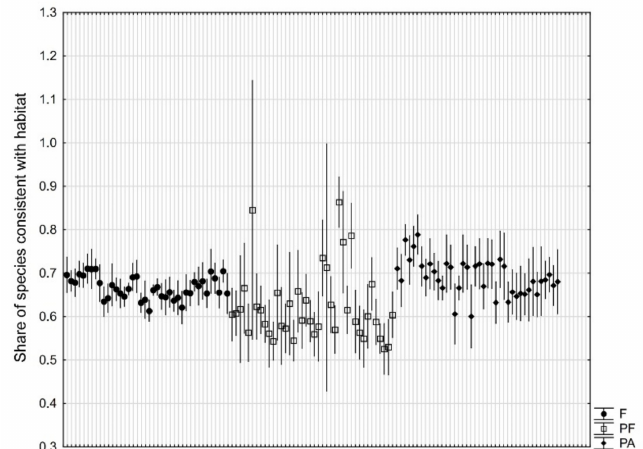
Figure 5. Number (mean ± 95% confidence interval based on 10 research plots of 100 m 2 ) of plant species consistent with Tilio-Carpinetum habitat in natural forests (F), manor parks adjacent to forests (PF), and manor parks not adjacent to forests